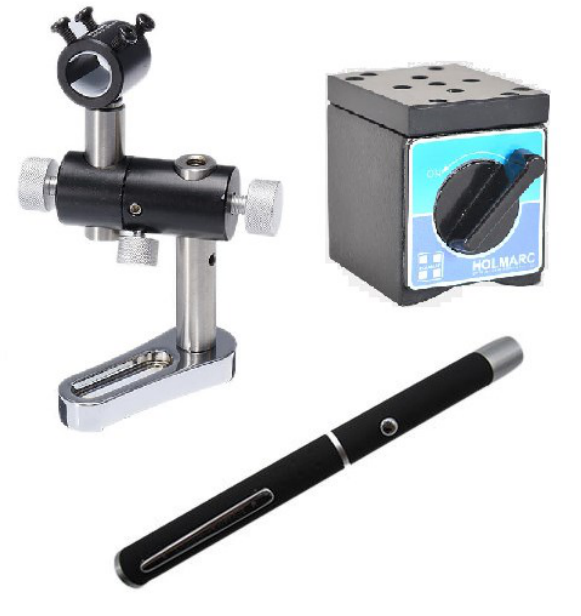
Figure 3. The laser pointer, the three axis adjustable laser pointer module holder, and the switchable magnetic post basis